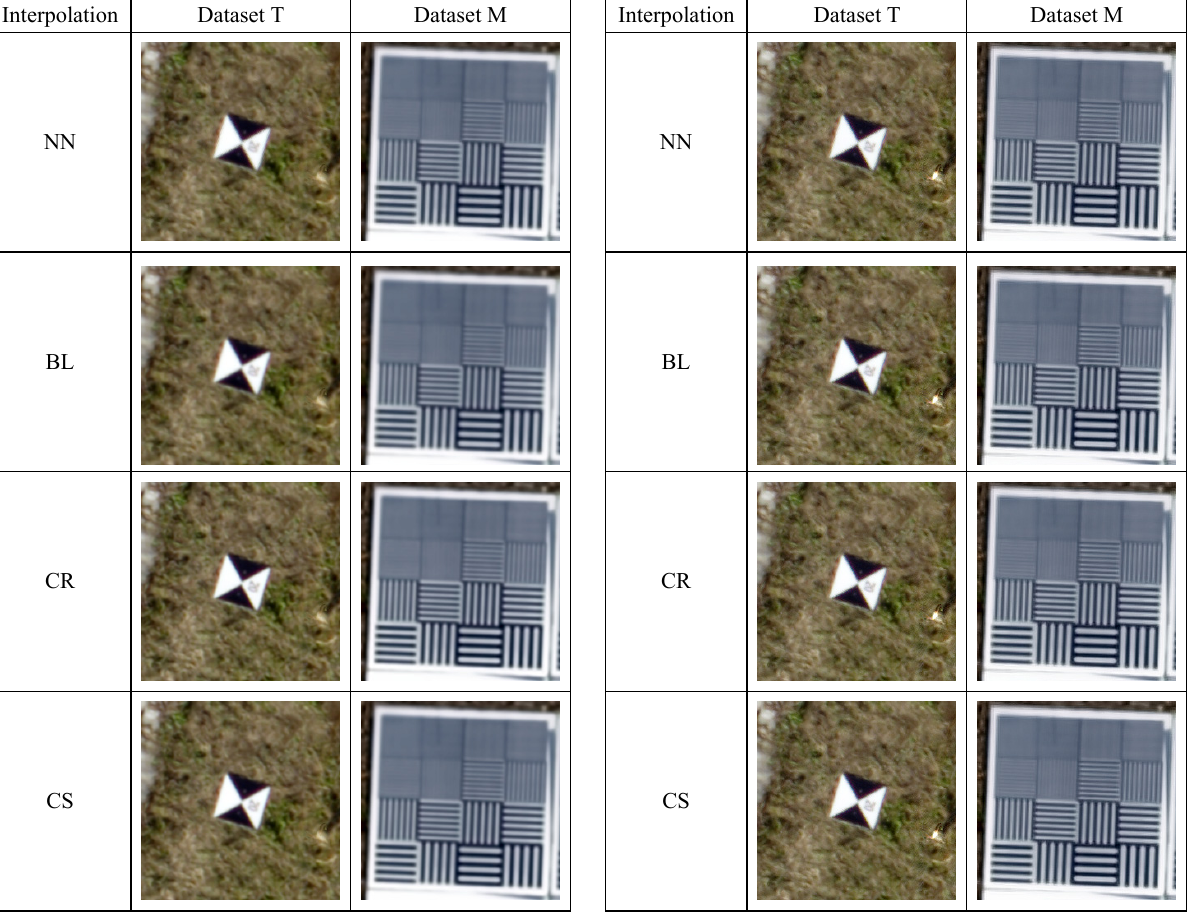
Figure 10. Results of SR-O by using a square wave Figure 9. Results of SR by resampling Figure 9. Results of